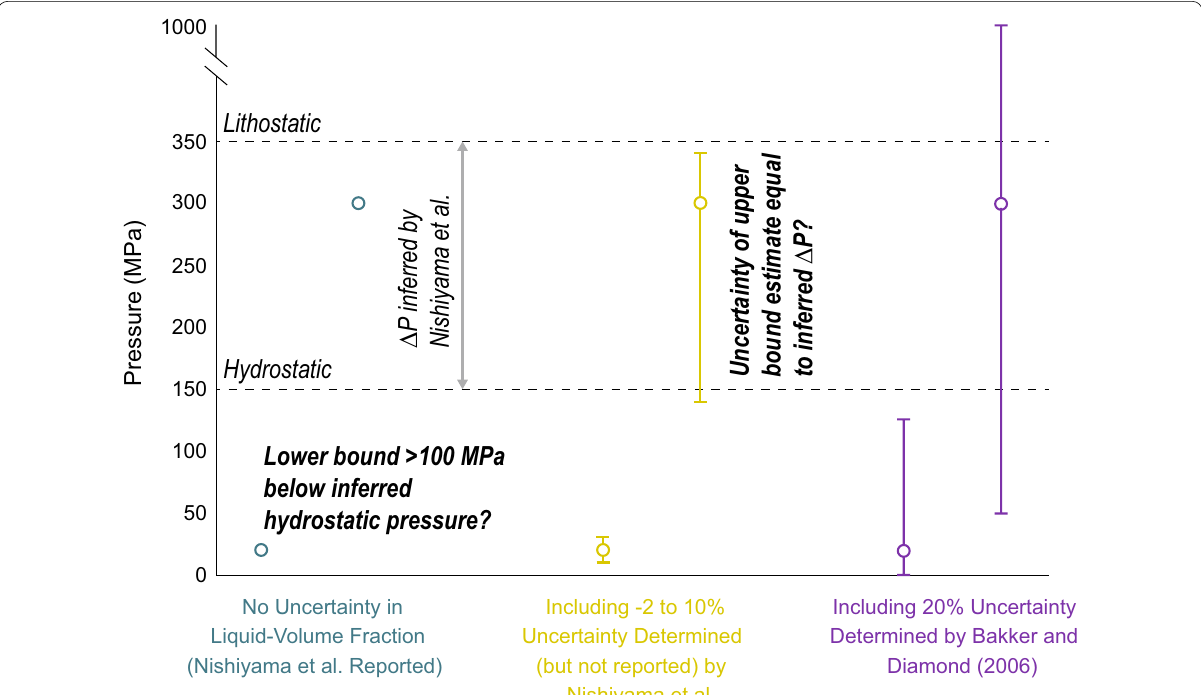
Fig. 1 Plot showing estimated pore-fluid pressures from Nishiyama et al.’s Fig. 4j without uncertainty as presented by Nishiyama et al. (left, green), with associated uncertainties determined (but not reported) by Nishiyama et al. (center, yellow), and with associated uncertainties suggested in a systematic analysis of liquid-volume fraction estimates by Bakker and Diamond (2006) (right, purple). Gray line shows the slip-induced decrease in pore-fluid pressure (ΔP) inferred by Nishiyama et al. based on the raw data. Note the discontinuous vertical axis above pressures of 350 MPa. When reasonable uncertainties in the estimated liquid-volume fractions are considered, the upper bound pressure estimate (which is inferred by Nishiyama et al. to record vein formation under lithostatic conditions) is indistinguishable from their estimate of the hydrostatic pressure at 15 km depth. Thus, when combined with an assumed minimum pressure consistent with hydrostatic conditions (as Nishiyama et al. argue), an interpretation of